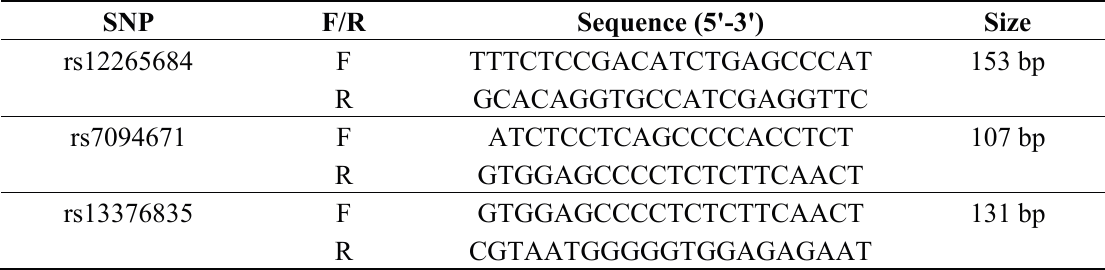
Table 5. Primer sequences used for the HRM